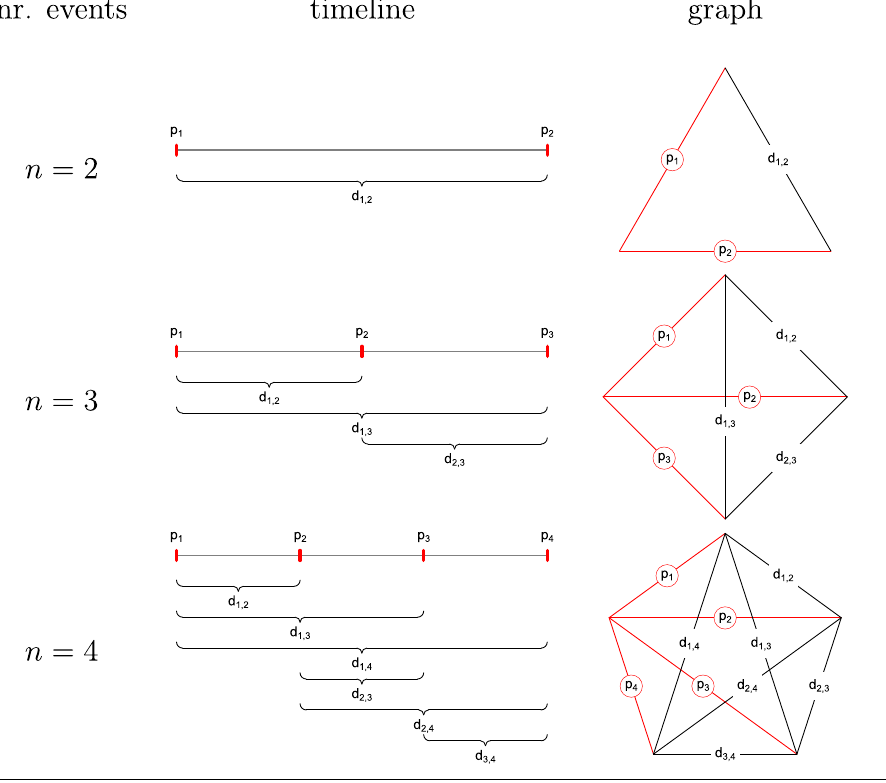
Table 3 Event-duration timeline and graph for two, three, and four event